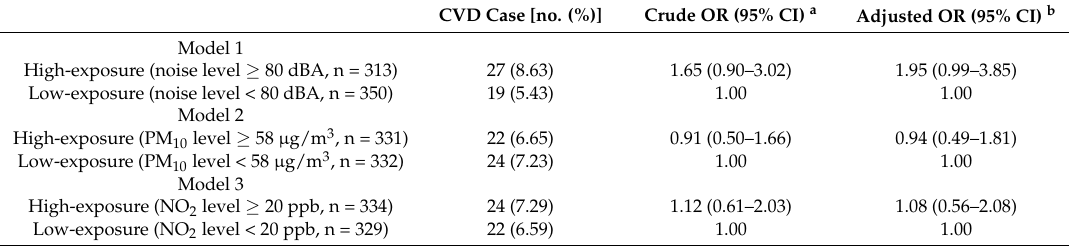
Table 4. Associations between single-exposure groups and the prevalence of cardiovascular